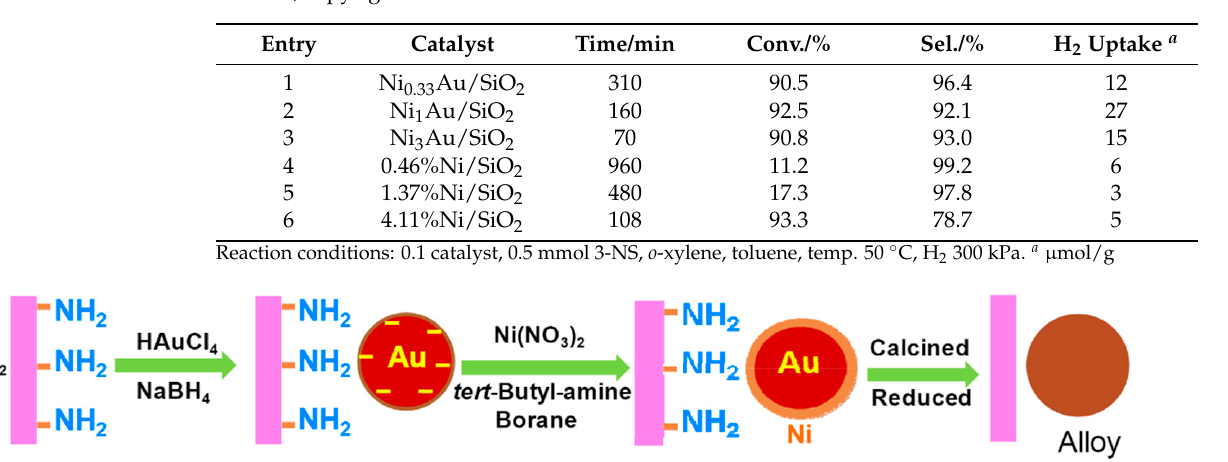
Table 3. Hydrogenation of 3-NS over various catalysts. Adapted from [11] with permission of Elsevier, copyright 2015.